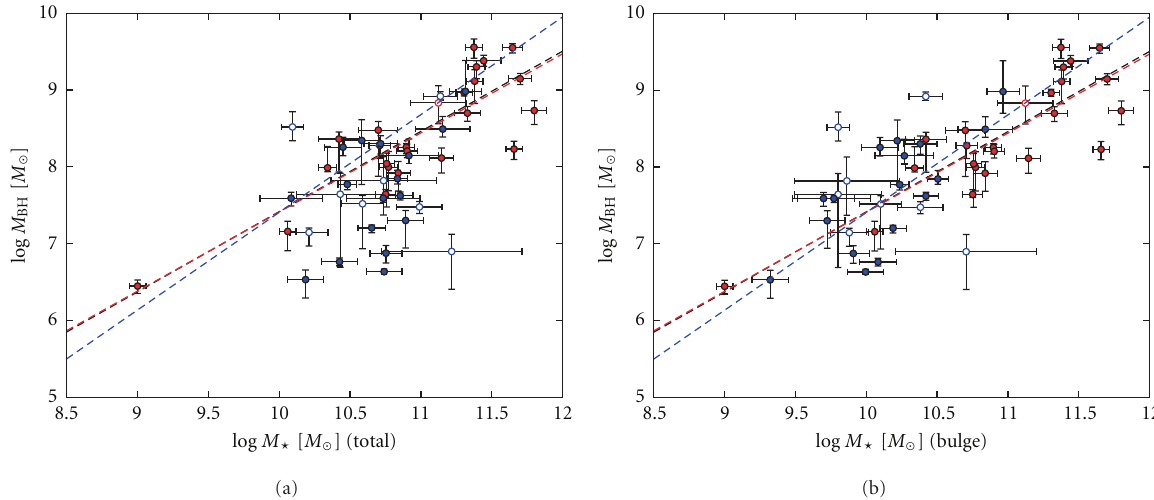
Figure 2: (a): SMBH mass (red: elliptical galaxies, blue: disk galaxies) versus total galaxy stellar mass. (b): SMBH mass versus bulge stellar mass. (Data and sources in Table 1). The diagonal dashed lines are the best fits to the M BH - M (cid:2) ,bul relation for the whole sample (black), for the elliptical galaxies (red), and for bulges of the disk galaxies (blue). Open symbols are galaxies without precise distances, which are not used in the fits. It is clear that the SMBH masses of S0 and spiral galaxies (blue) correlate better with the bulge stellar mass than with total galaxy